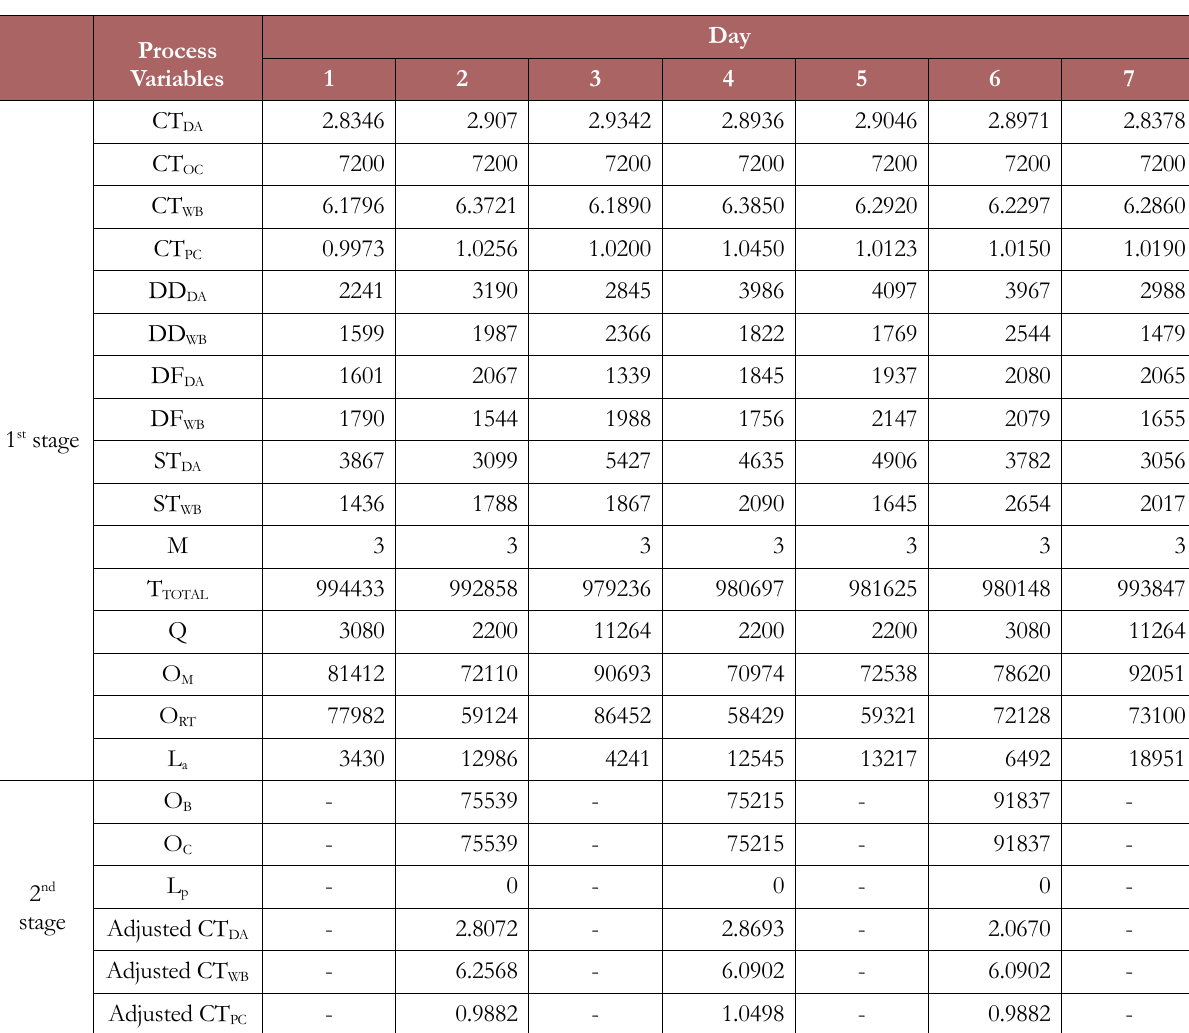
Table 2. 1 st Stage and 2 nd Stage of Production Planning for 1 st